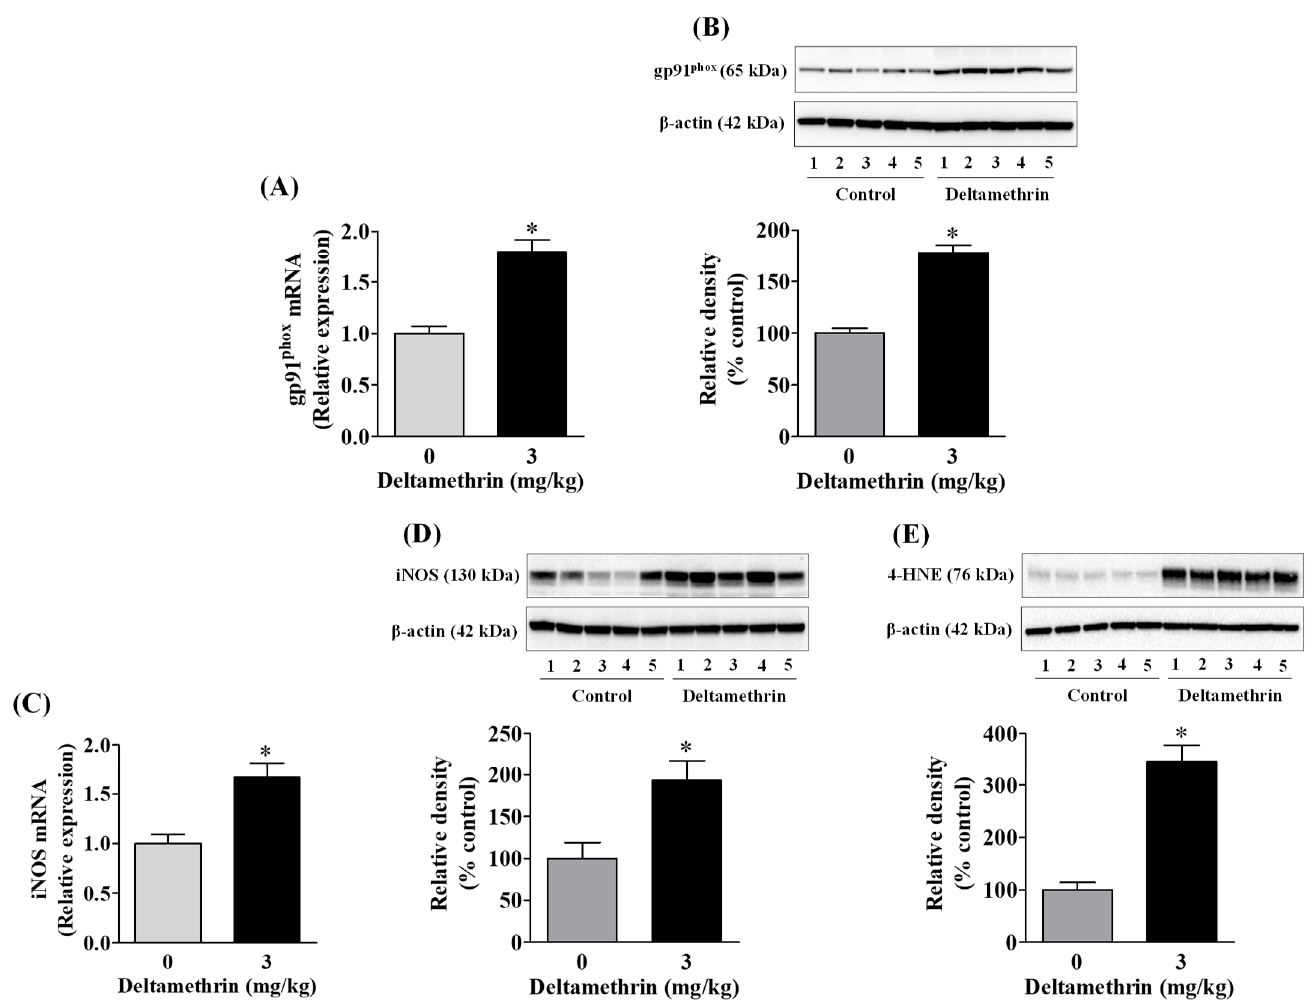
Figure 3. Deltamethrin exposure increases oxidative and nitrosative enzymes in the hippocampus. ( A ) mRNA and ( B ) protein levels of gp91 phox , ( C ) mRNA and ( D ) protein levels of iNOS, and ( E ) protein levels of 4-HNE. The protein bands were quantified by densitometry from Western blot analysis, and the results reported as relative band densities in bar graphs. An asterisk denotes significant difference from the control ( p < 0.05).